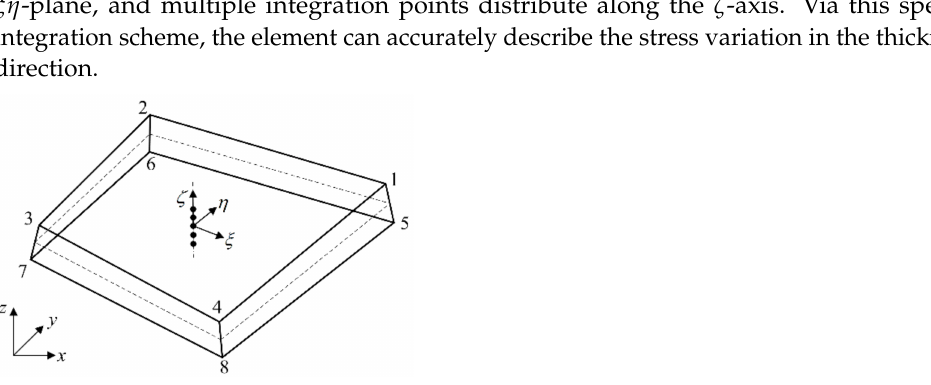
Figure 1. Solid-shell element with integration points. Adapted from Ref. [22] with permission from John Wiley and Sons